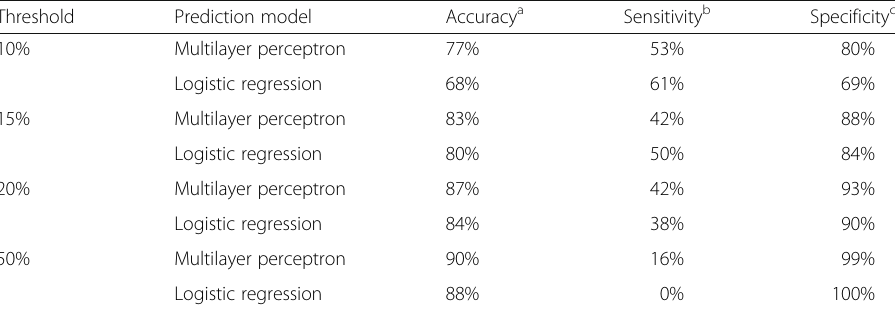
Table 3 Accuracy, sensitivity, and specificity of the two models with different thresholds Threshold Prediction